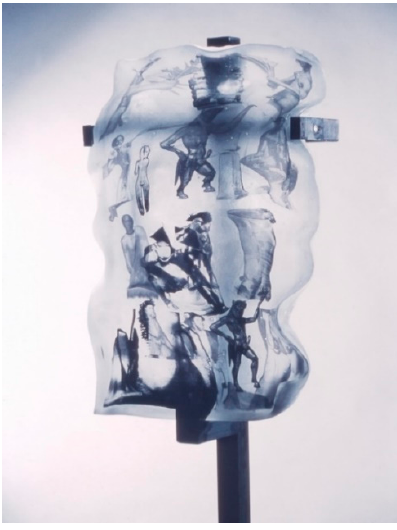
Figure 2. Goshka Bialek; Newspaper , 2002; inclusion of screen-printing images on transfer paper in glass; 180 cm × 50 cm × 30 cm; photographed by Tim Adams, used by permission.